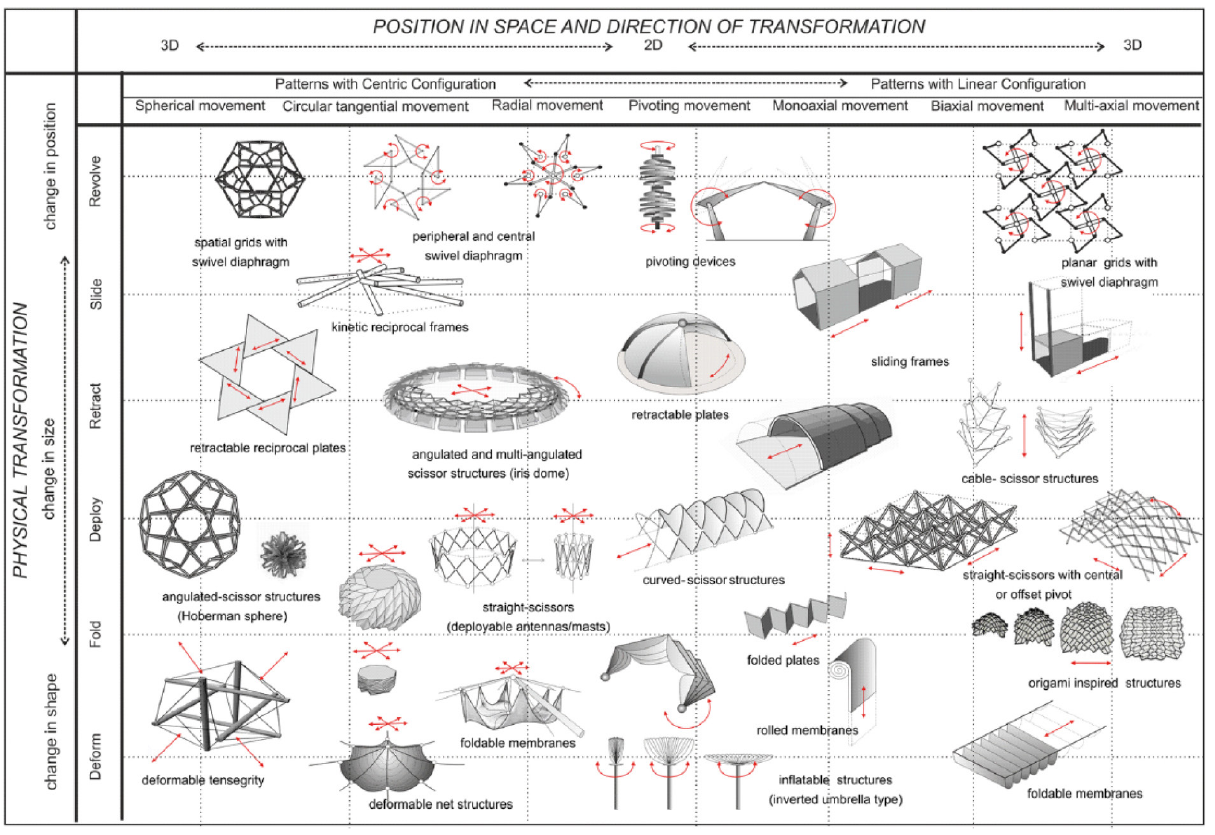
Figure 10: Classification by Stevenson from